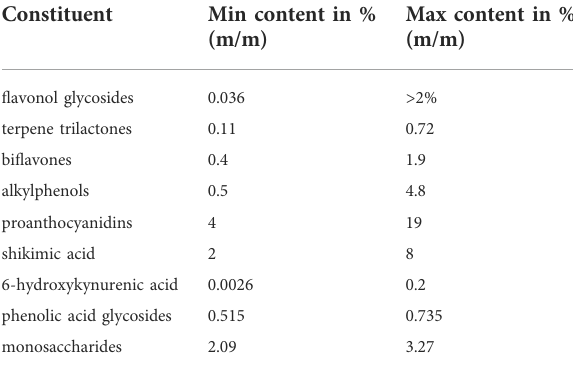
TABLE 1 Summary of min/max. concentrations of constituents in G. biloba leaves according to current literature data and in cases of the fl avonol glycosides and PACs own data on upper limits.